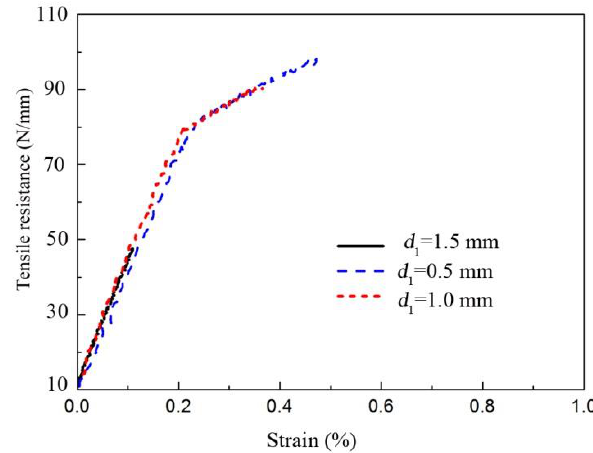
Figure 11. Stress-strain curves of the steel/Al joints obtained by dual-beam laser welding with side-by-side configuration for three different d 1 .